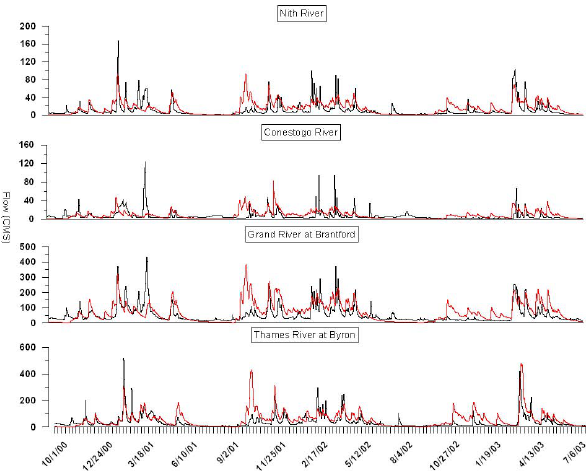
Fig. 8. WATFLOOD model results for selected southern Ontario basins. Red lines are the simulated hydrographs, black lines are the